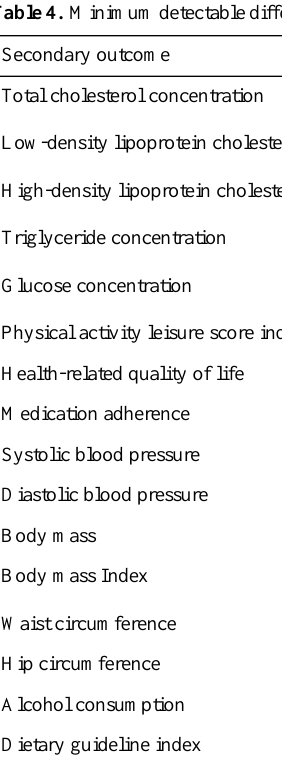
Table 4. Minimum detectable differences in secondary outcomes (assuming a total sample size of 220 participants [110 per treatment arm] and beta=.8).